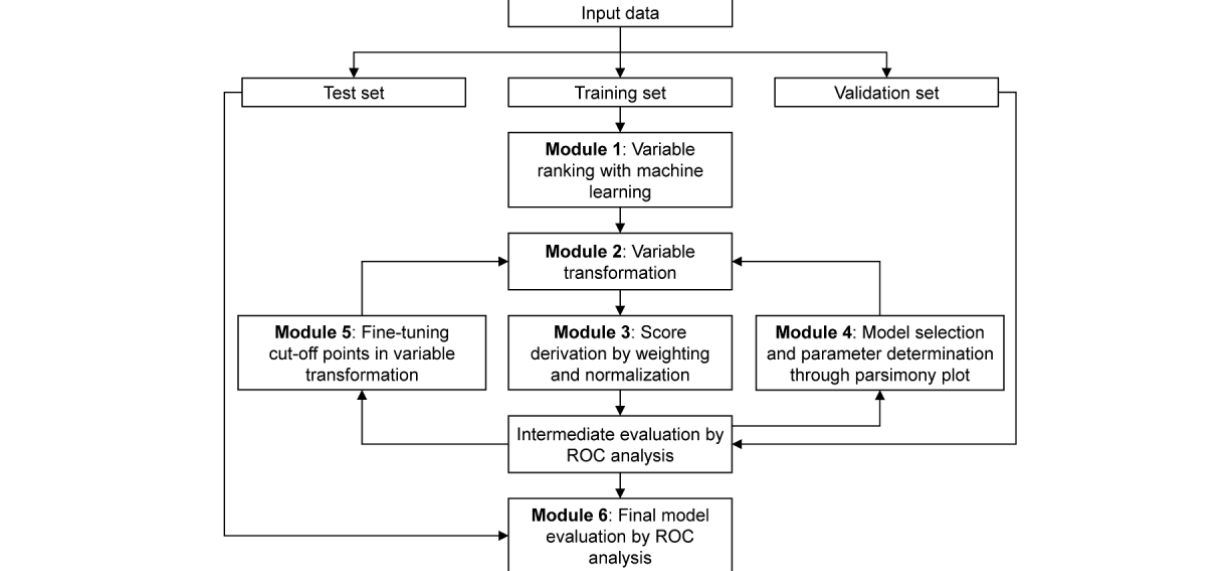
Figure 1. Flowchart of the AutoScore framework. ROC: receiver operating